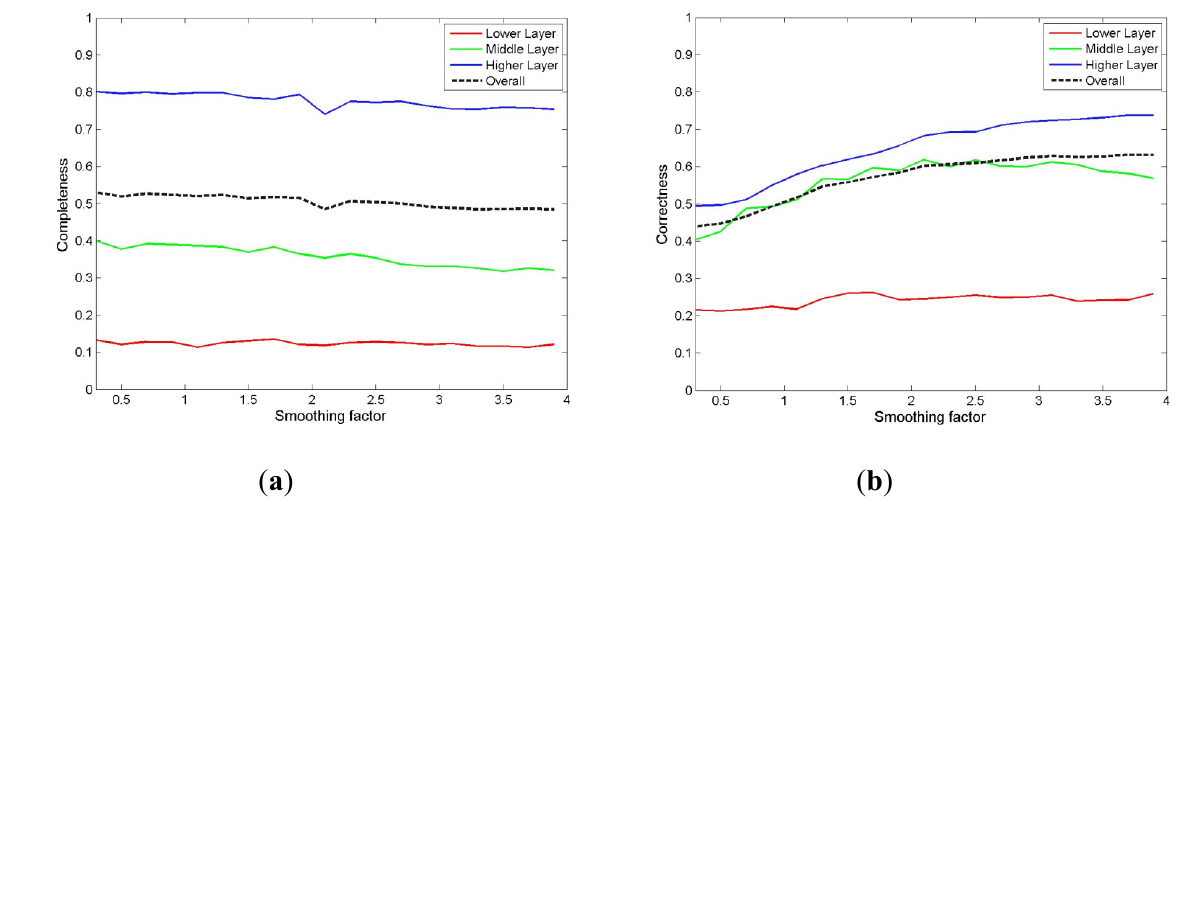
Figure 8. Sensitivity analysis with respect to the parameter λ for the dataset of Test Site I acquired under leaf-on condition, ( a ) Completeness; ( b ) Correctness; colored lines indicate the forest